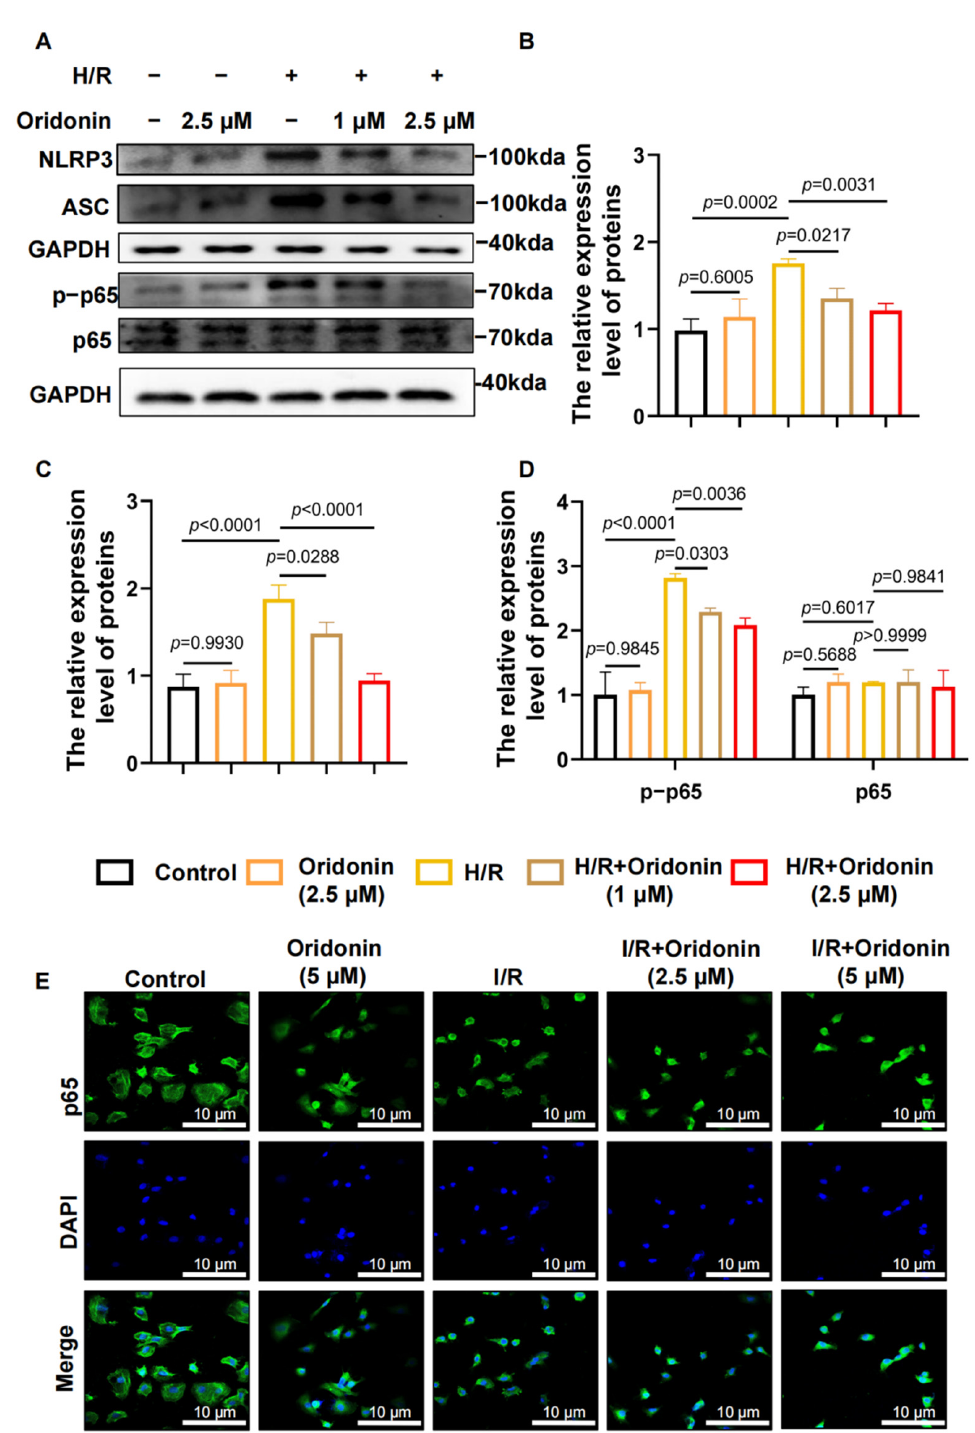
Figure 4. Oridonin participates in the regulation of the NF- κ B/NLRP3 signaling pathway. ( A ) Repre- sentative western blot results of NLRP3, ASC, p65, and p-p65 from each group. ( B ) Densitomet- ric quantification of NLRP3 based on ( A ). ( C ) Densitometric quantification of ASC based on ( A ). ( D ) Densitometric quantification of the ratio of p65/p-p65 based on ( A ). ( E ) Representative immuno- histochemistry results in NRCMs from each group. All samples are from NRCMs. The protein level was standardized using GAPDH. In all cases, the data are expressed as the mean ± SD. To elucidate the pathway by which oridonin affects the NLRP3 inflammasome, we pretreated NRCMs with a mixed inhibitor containing 5 μ M Bay-117082 (NF- κ B inhibitor),